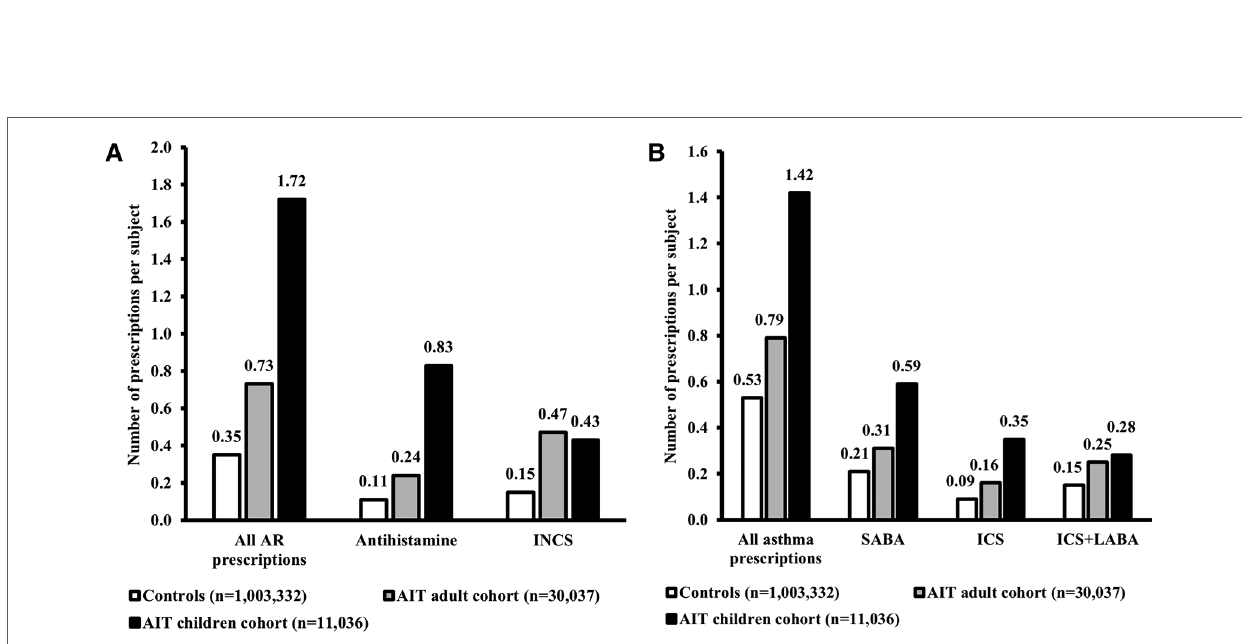
FIGURE 4 Medication use for AR ( A ) and asthma ( B ). Data presented are from the 1-year period before the index date (i.e., the fi rst prescription for AIT during the study period) for children and adults in the AIT group, and for control subjects (i.e., all AR subjects without prescriptions for AIT) (47). The “ All AR prescriptions ” and “ All asthma prescriptions ” data for AR subjects without AIT have been published previously (47). AIT, allergy immunotherapy; AR, allergic rhinitis; ICS, inhaled corticosteroid; INCS, intranasal corticosteroid; LABA, long-acting beta agonist; SABA, short-acting beta